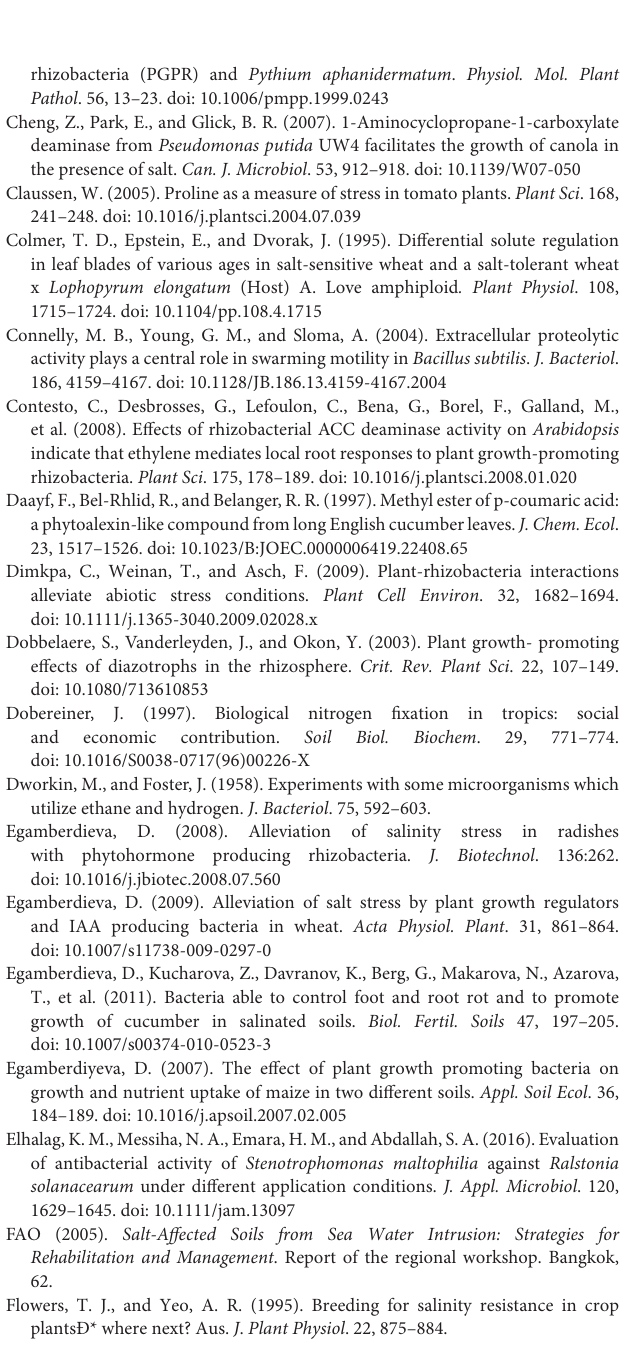
Supplementary Figure 1 | Phylogenetic tree showing the relationship of S. maltophilia SBP-9 to closely related bacteria. PCR amplified amplicon of partial 16S rRNA gene of SBP-9 was sequenced and used for the construction of a phylogenetic tree. The 16S rRNA gene sequence of closely related species was obtained from NCBI GenBank database.